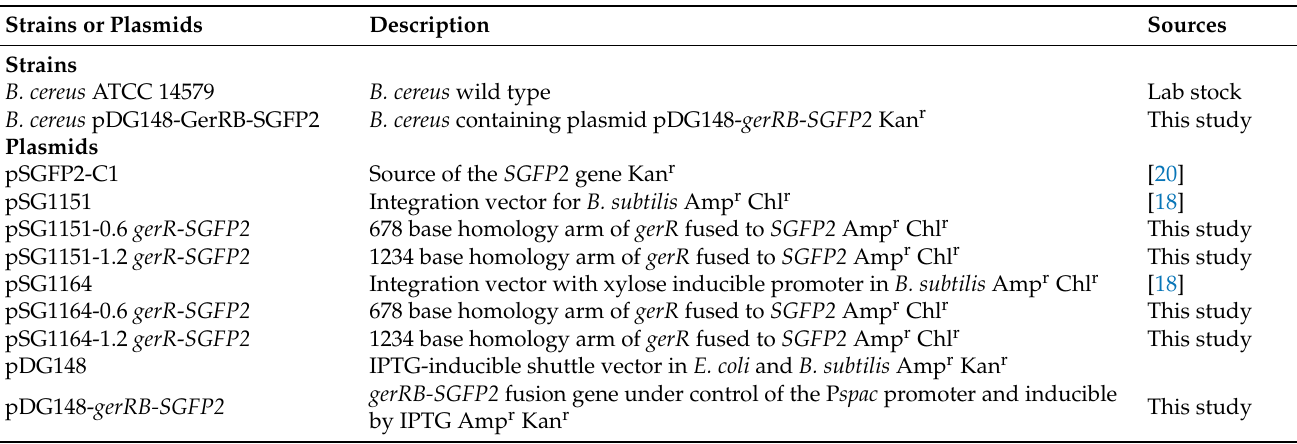
Table 1. Strains and plasmids used or created in this study